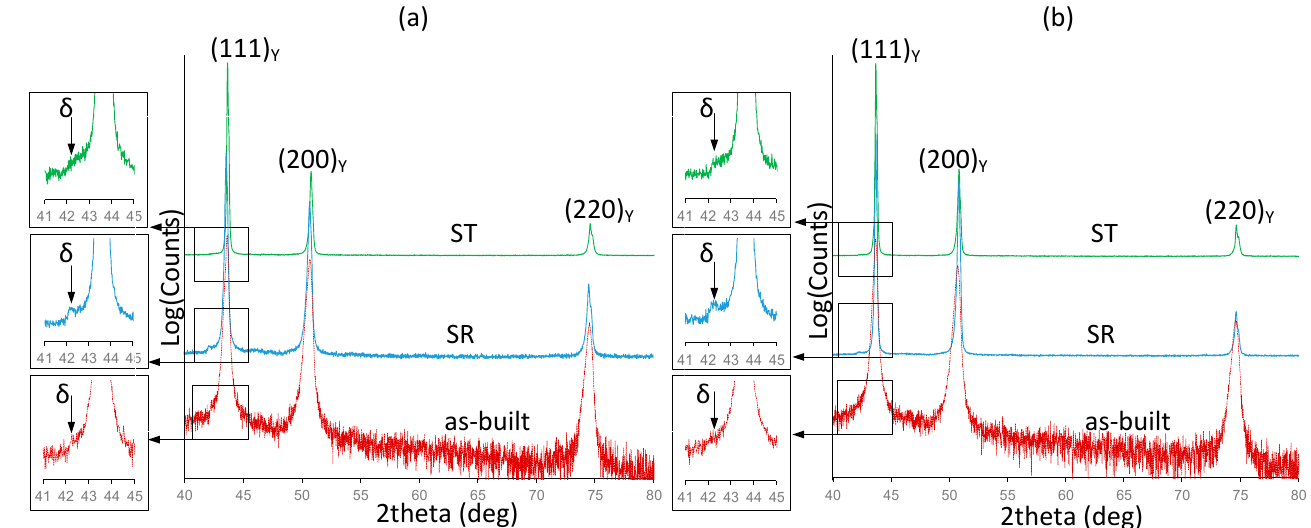
Figure 2. X-ray diffraction patterns of the as-built and heat-treated IN625 alloys: ( a ) Alloy 1; ( b ) Alloy 2.